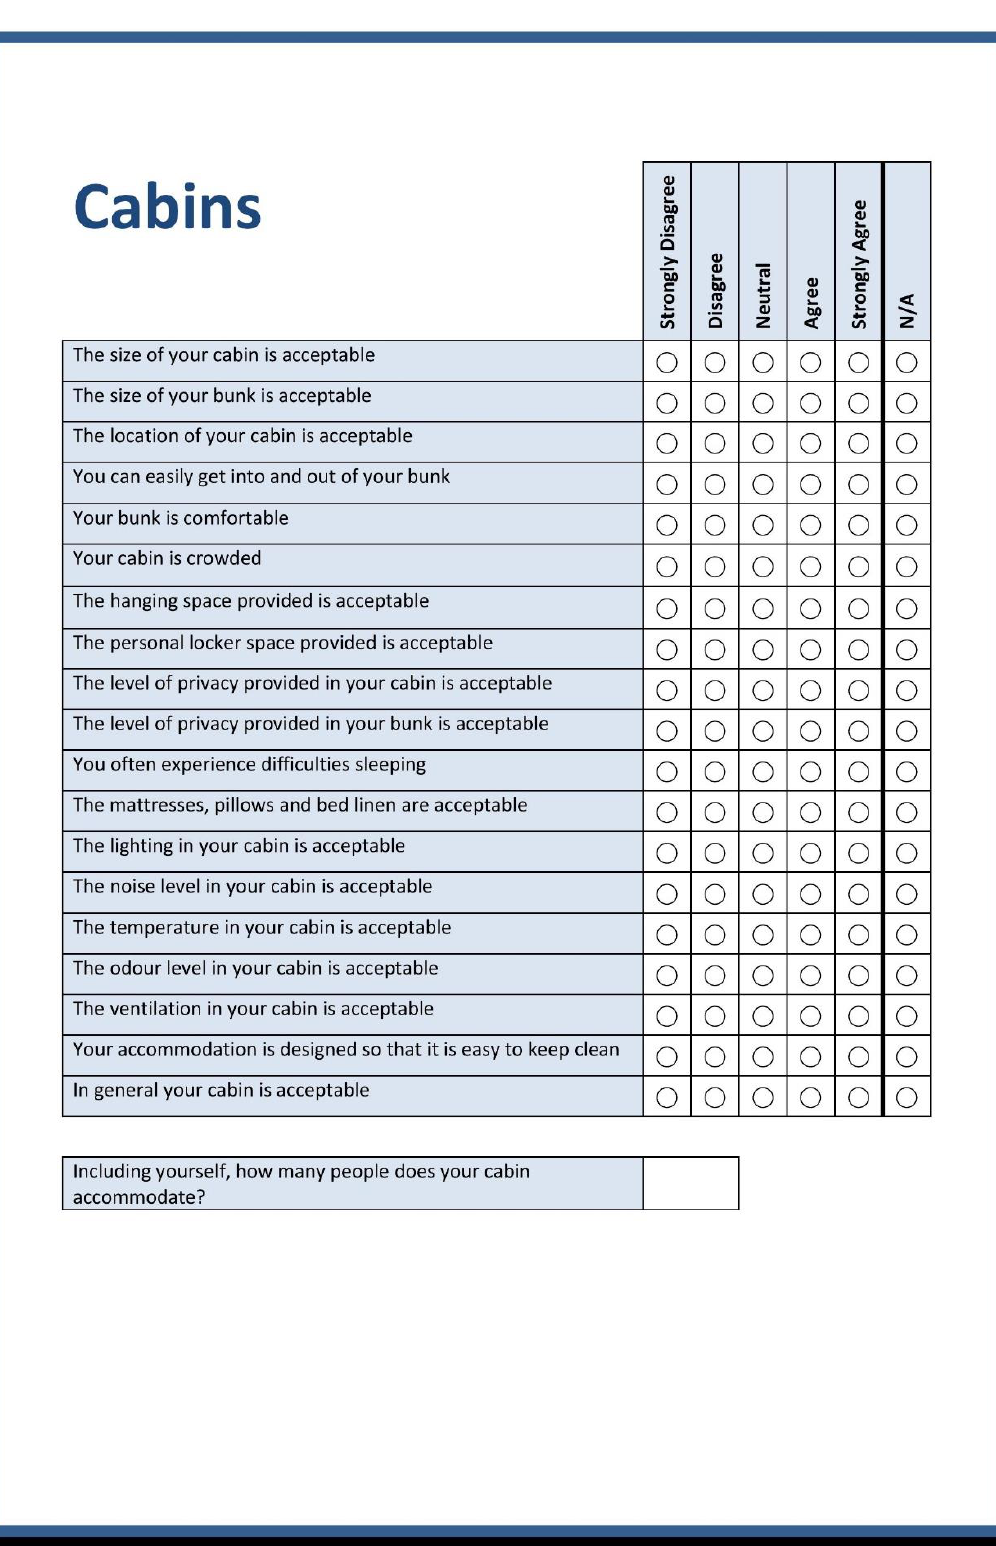
Figure A8. The Submarine Habitability Assessment Questionnaire (continued).